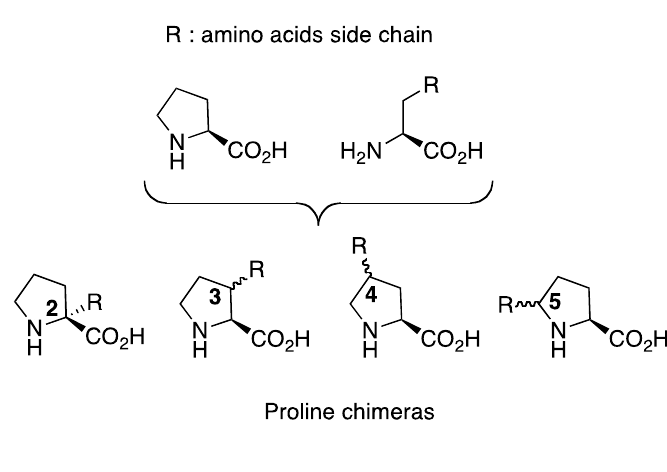
Figure 2. Four types of proline